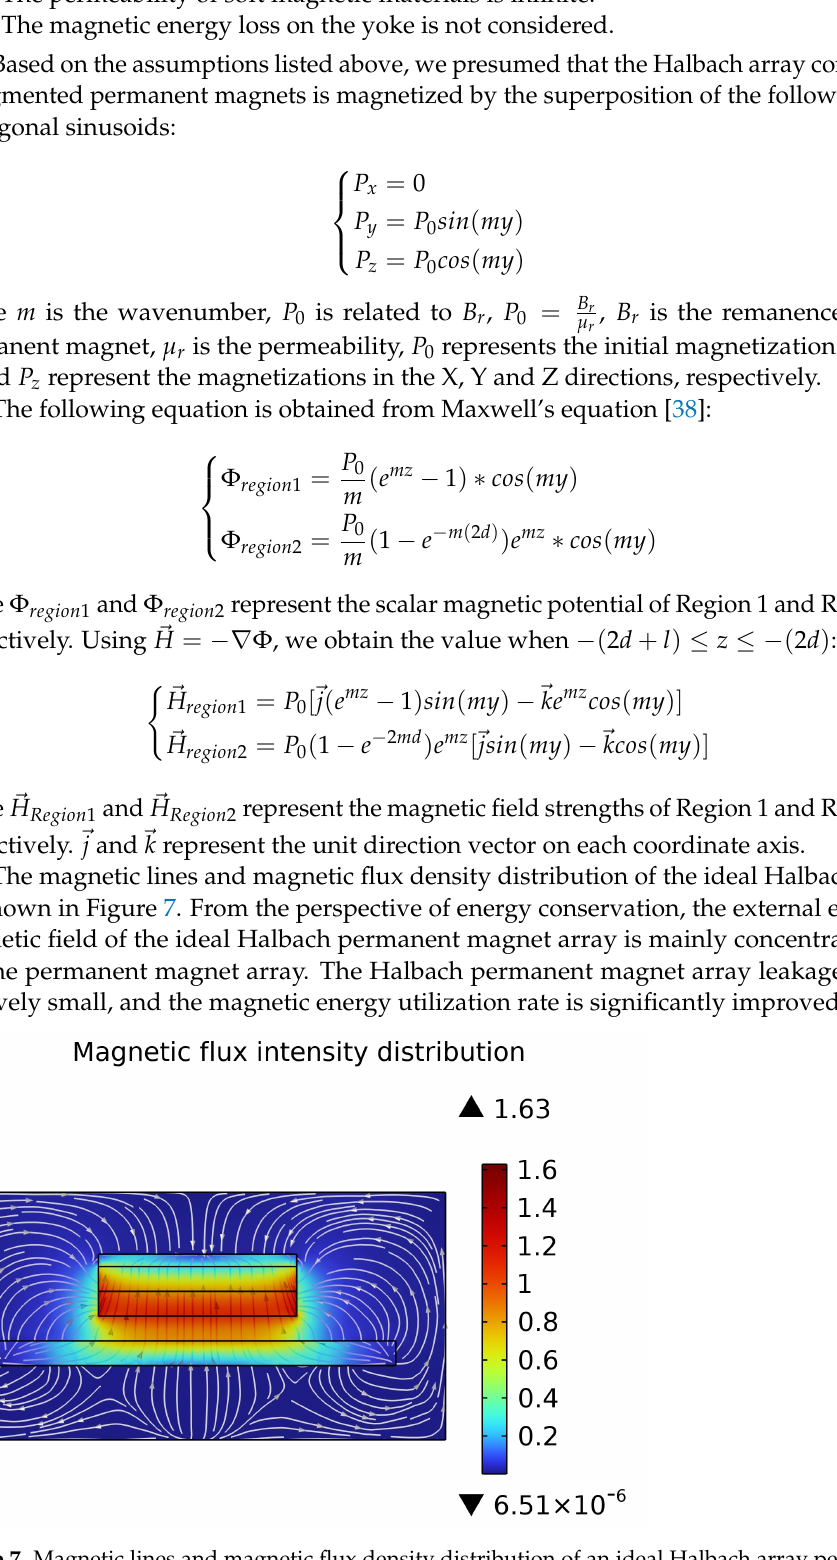
Figure 7. Magnetic lines and magnetic flux density distribution of an ideal Halbach array permanent magnetic